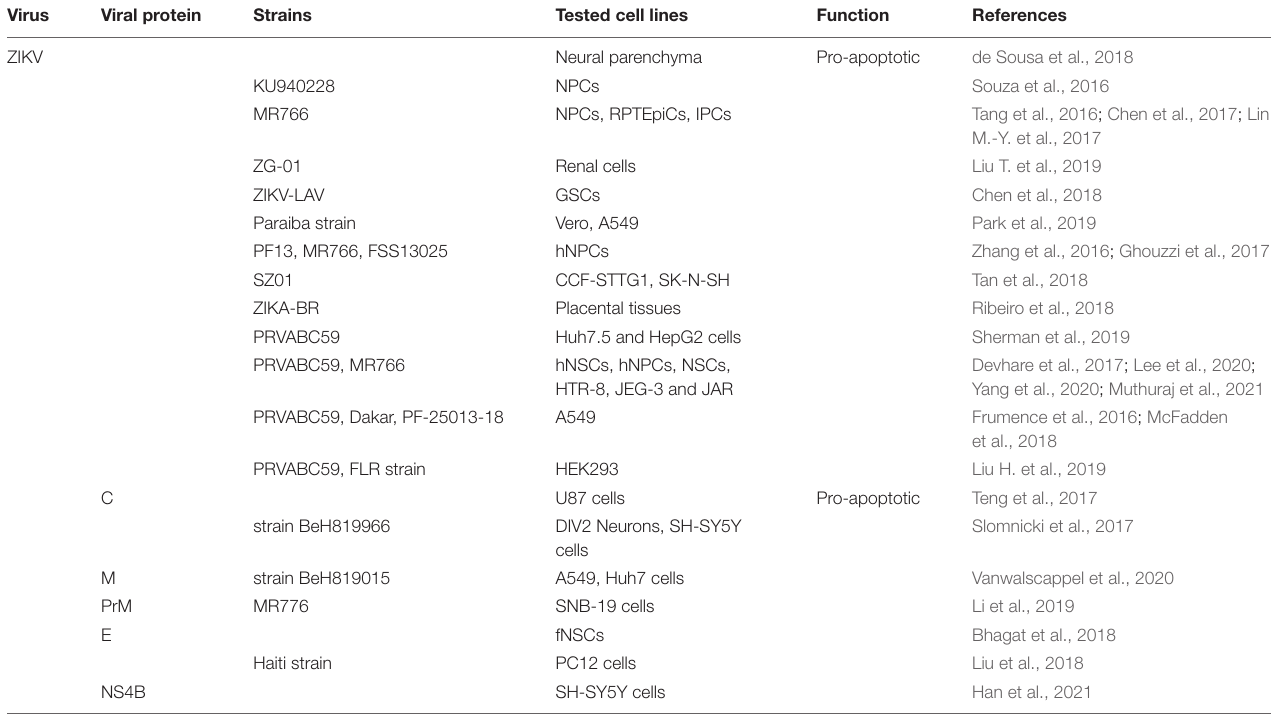
TABLE 4 | Pro-apoptotic or anti-apoptotic activity of ZIKV and its proteins. Virus